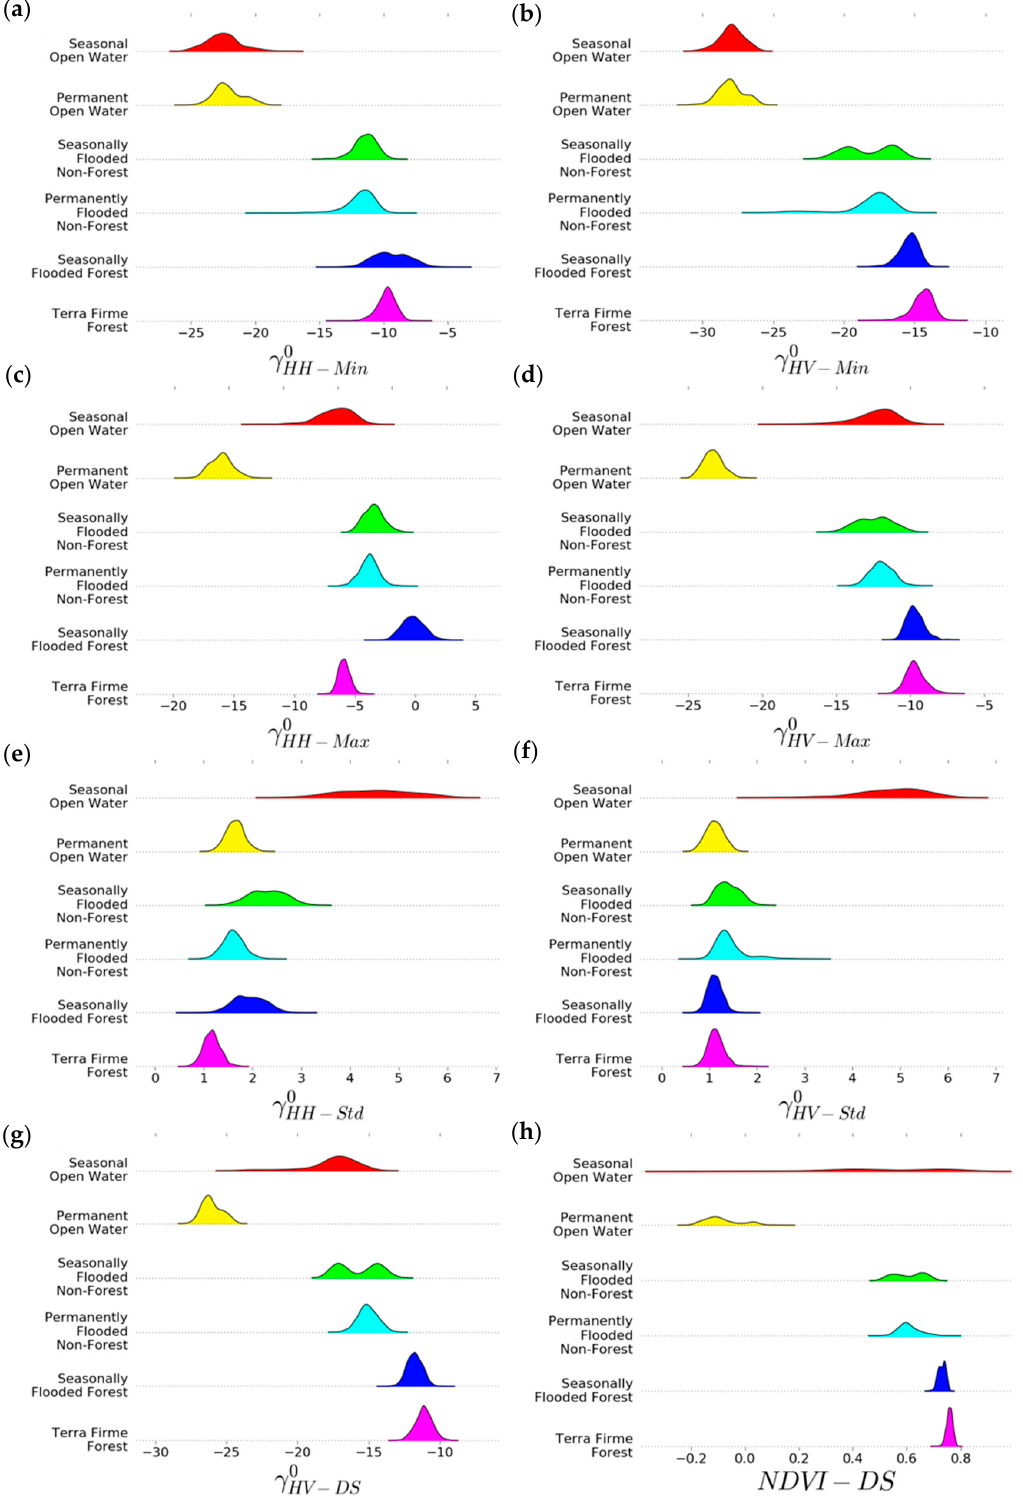
Figure 7. Distribution of multi-temporal γ 0 and NDVI statistics by land cover type from selected ROIs representing a variety of landcover classes: ( a ) γ 0 decision tree classification are developed from these